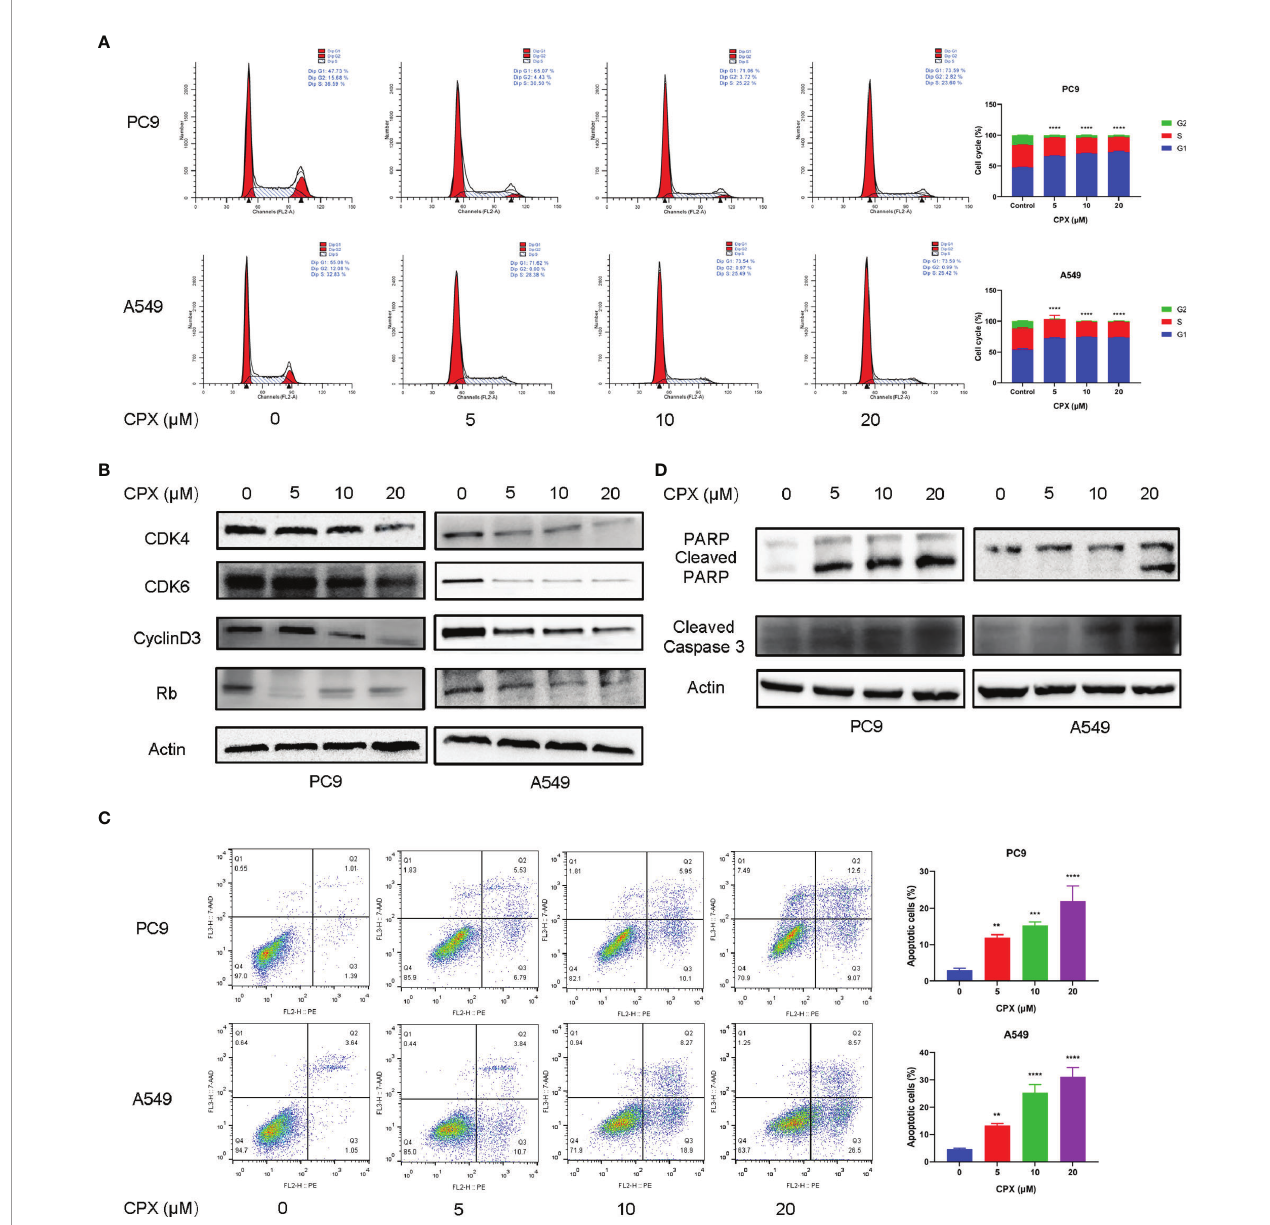
FIGURE 2 | CPX induces cell cycle arrest and apoptosis. (A) Cell-cycle distribution was analyzed by fl ow cytometry after cells were treated with indicated CPX concentrations for 24 hours. (B) Western blotting of cell cycle-related protein levels in cells treated with indicated CPX concentrations for 24 hours. (C) Cells treated with indicated CPX concentrations for 24 hours were fi xed, stained with PE/7-AAD, and analyzed by fl ow cytometry. (D) Western blotting of apoptosis-related proteins in cells treated with indicated CPX concentrations for 24 hours. **P < 0.01; ***P < 0.001; ****P < 0.0001. Statistical signi fi cance compared with respective control